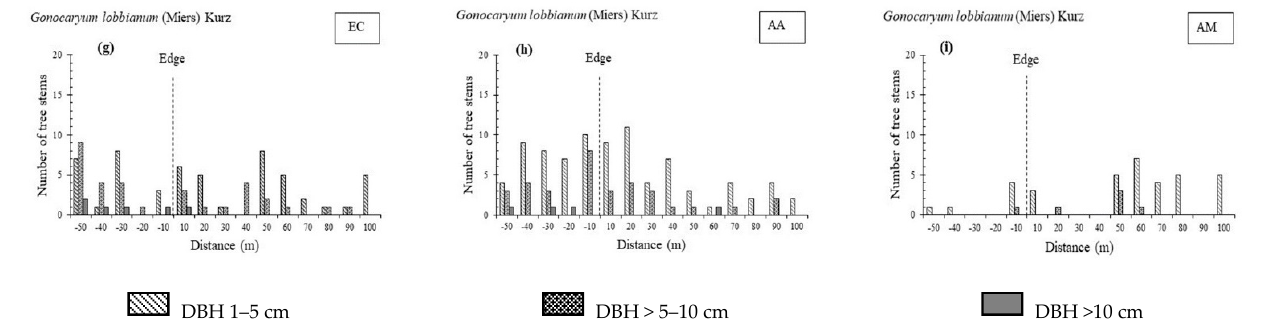
Figure 5. Diameter class distribution of some pioneer tree species along the forest remnants to plantation stands of three exotic plantations. ( a – c ) Wrightia arborea in Eucalyptus camaldulensis (EC), Acacia auriculiformis (AA), and A. mangium stands, ( d – f ) Microcos tomentosa in EC, AA and AM stands, ( g – i ) Gonocaryum lobbianum in EC, AA and AM stands.